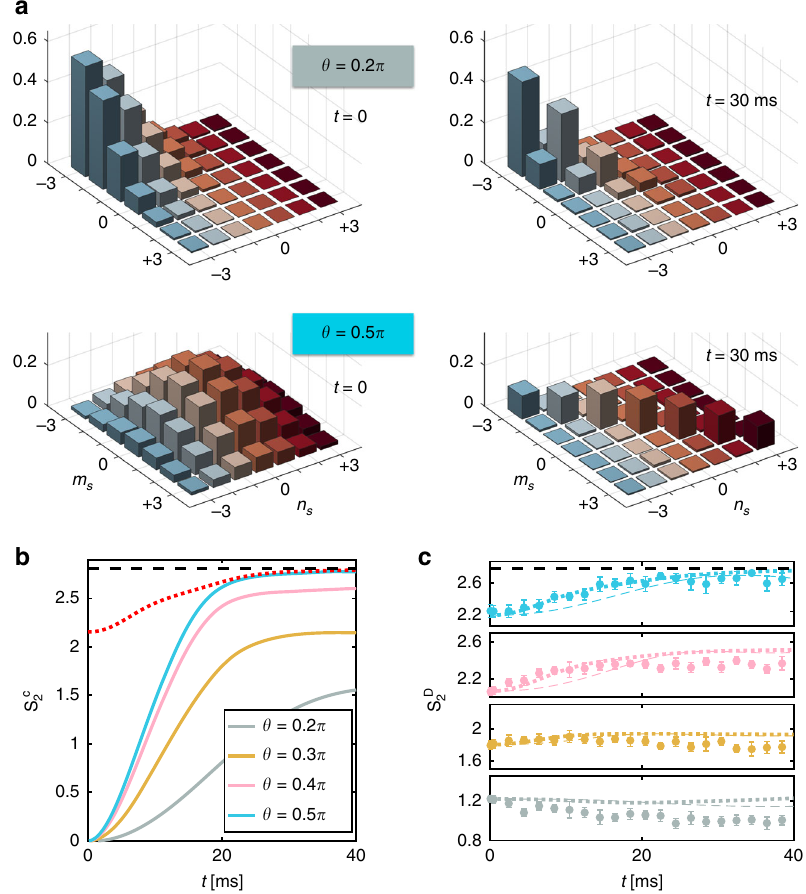
Fig. 4 Entanglement buildup. a Absolute values of the central spin density-matrix elements j ρ c m j with ρ c m (cid:3) h m S j ^ ρ 0 j n S i , extracted from GDTWA S ; n S s ; n S simulations with the same parameters as in Fig. 2. Off-diagonal single-site coherences are destroyed as the spins become entangled during the quantum dynamics (left two panels: t = 0, after the tilt, right two panels: after t = 30 ms evolution). For small rotation angles (upper panels: θ = 0.2 π ), the system evolves locally into a partially mixed state (uneven spin-state population). For larger rotation angles (lower panels: θ = 0.5 π ), the local state resembles a P 3 m m S c 1 maximally mixed state of the form ^ ρ , the value of the second-order Renyi entropy S ð 2 Þ for the central spin density S ih S i . b Evolution of m S ¼(cid:2) 3 j 0 / 2 0 7 matrix. For larger rotation angles, the entanglement entropy increases with time, almost reaching the maximum value ( S ð 2 Þ max 7 Þ , black dashed line). 0 ¼ log 2 ð The red dotted line shows the upper bound S D , computed only from the diagonal elements (populations) of the average single-site density matrix ^ ρ S (see 2 text) for θ = 0.5 π . c Comparison of the theoretically computed diagonal entropy (GDTWA: thick dotted line; mean- fi eld: thin dashed line) with the one reconstructed from the measured populations. Error bars correspond to statistical standard